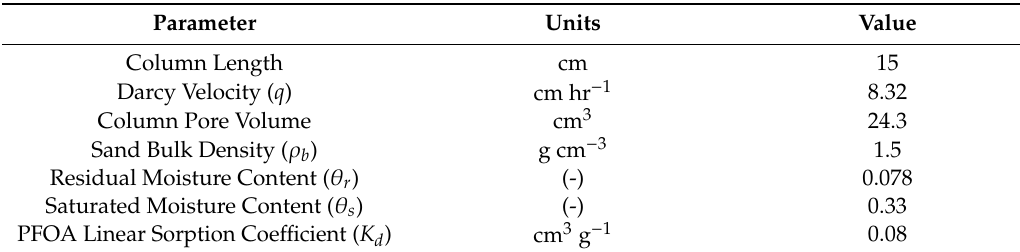
Table 1. Experimental Parameters derived from Lyu et al.